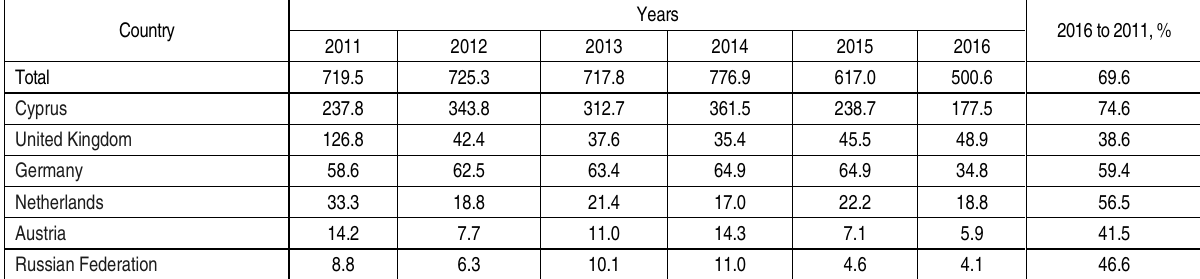
Table 4. Foreign direct investments into agriculture, forestry and fishery from individual countries,